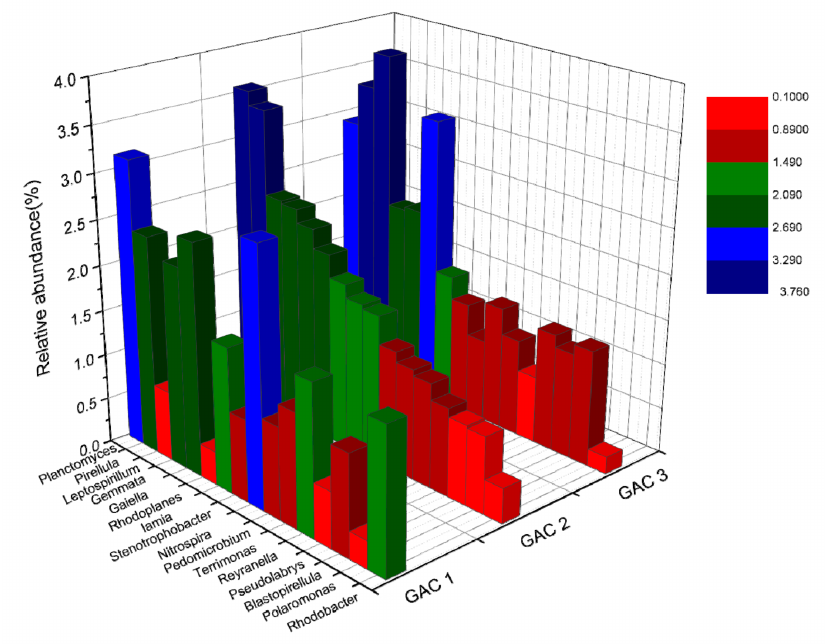
Figure 8. Microbial population classification of activated carbons from different carbon depths